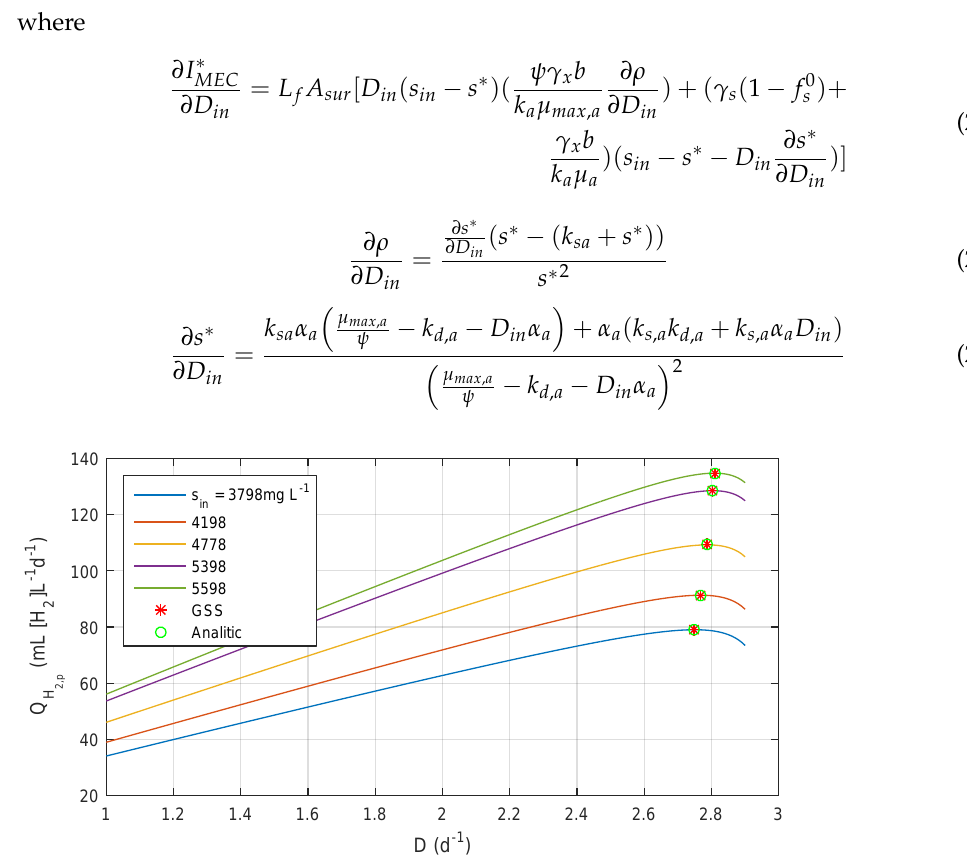
Figure 6. Hydrogen productivity for different s in .